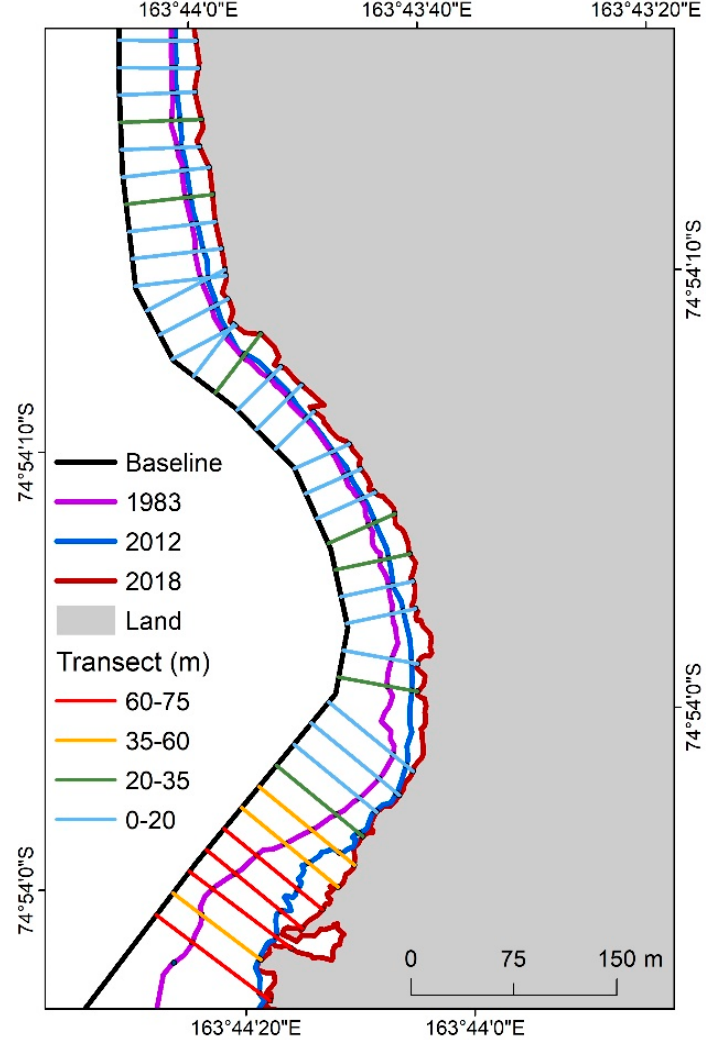
Figure 2. Dynamics of the shoreline on Inexpressible Island based on the Digital Shoreline Analysis System. The black line is the baseline. Cross-shore transects are each spaced by 20 m and shown in colors according to the distance between shorelines from 1983 to 2018. Shorelines in 1983, 2012 and 2018 are shown in purple, blue and red, respectively.